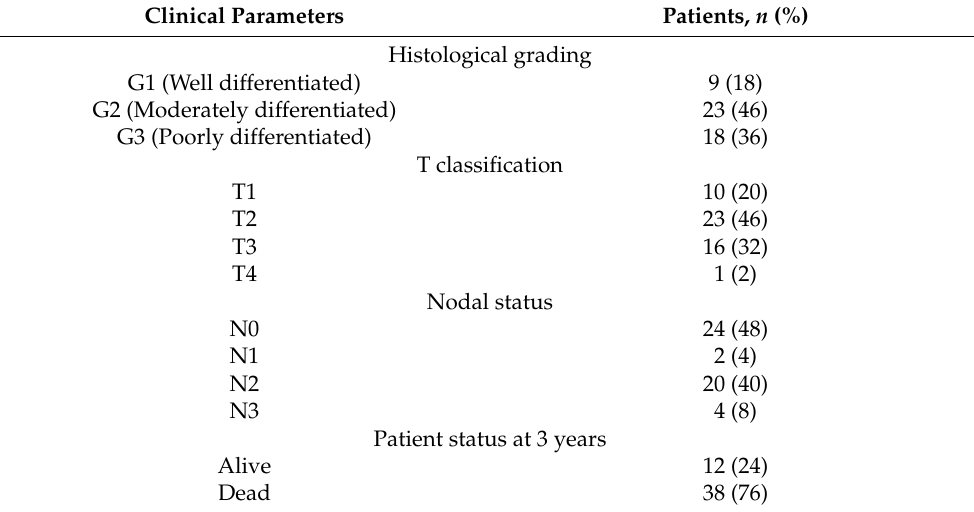
Table 1. Clinical parameters of the OSCC